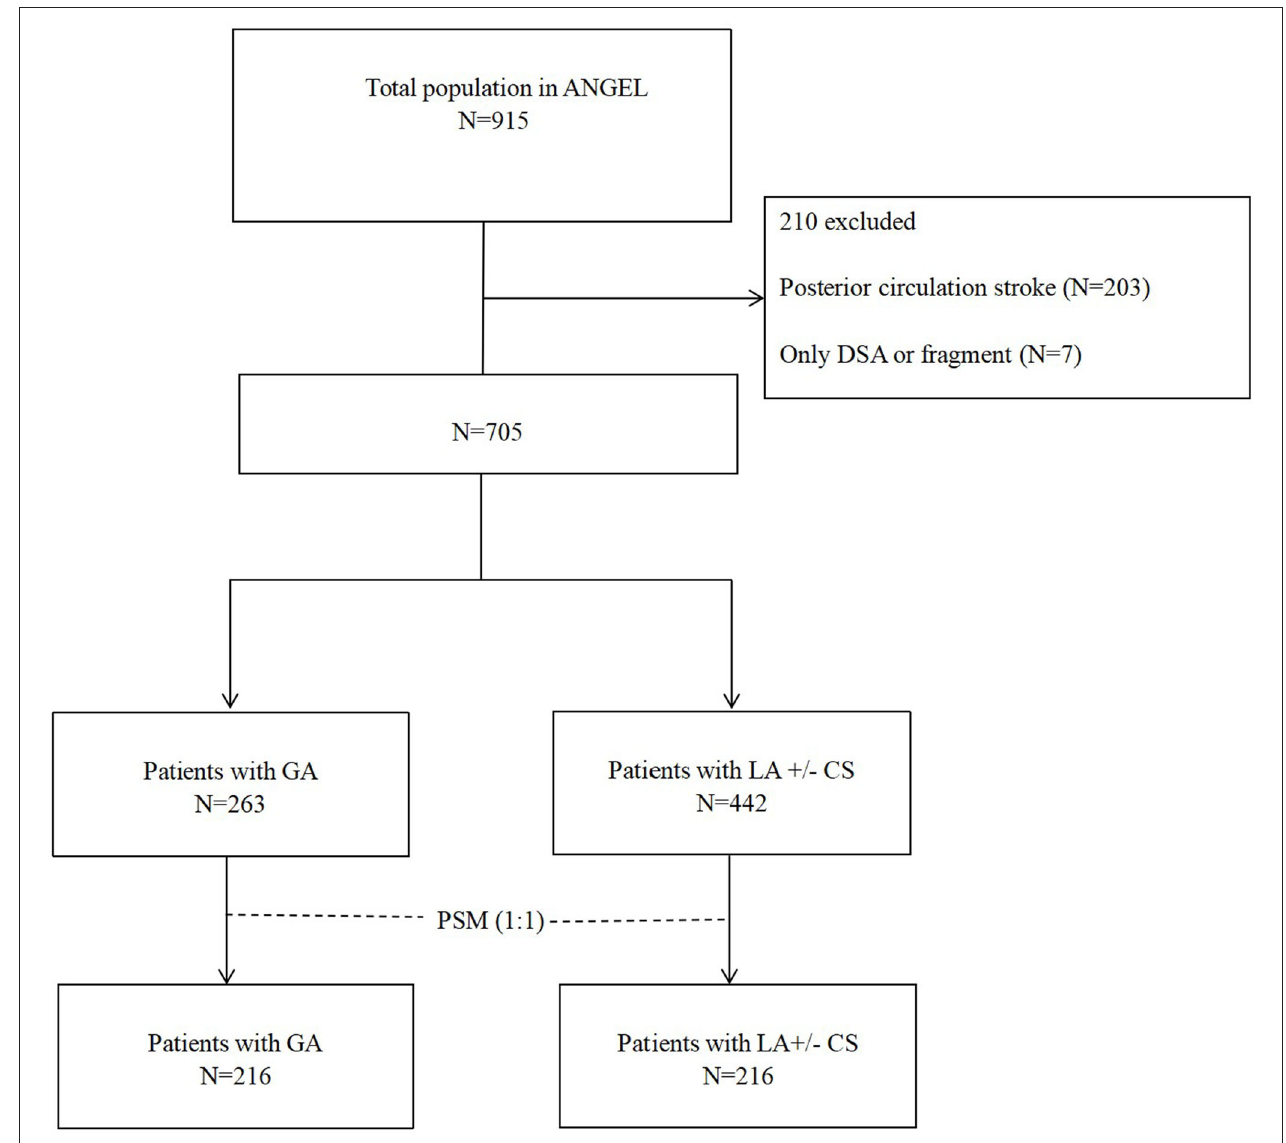
FIGURE 1 | Flowchart of patient selection. PSM, propensity score matching; GA, general anesthesia; LA, local anesthesia; CS, conscious sedation; DSA, digital subtraction